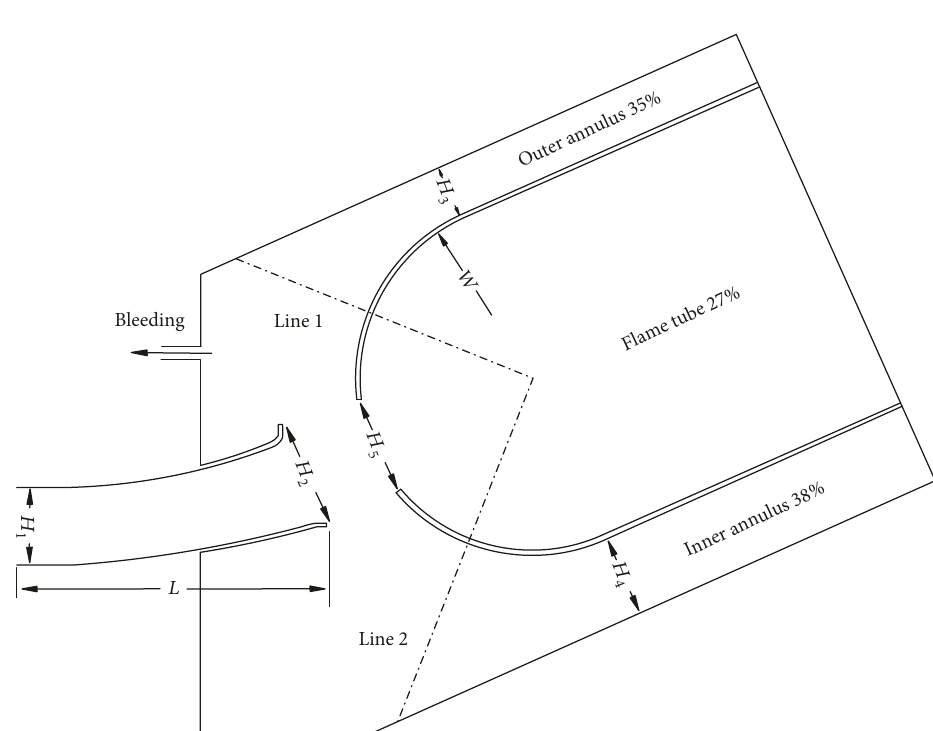
Figure 3: Idealized physical model of dump di ff